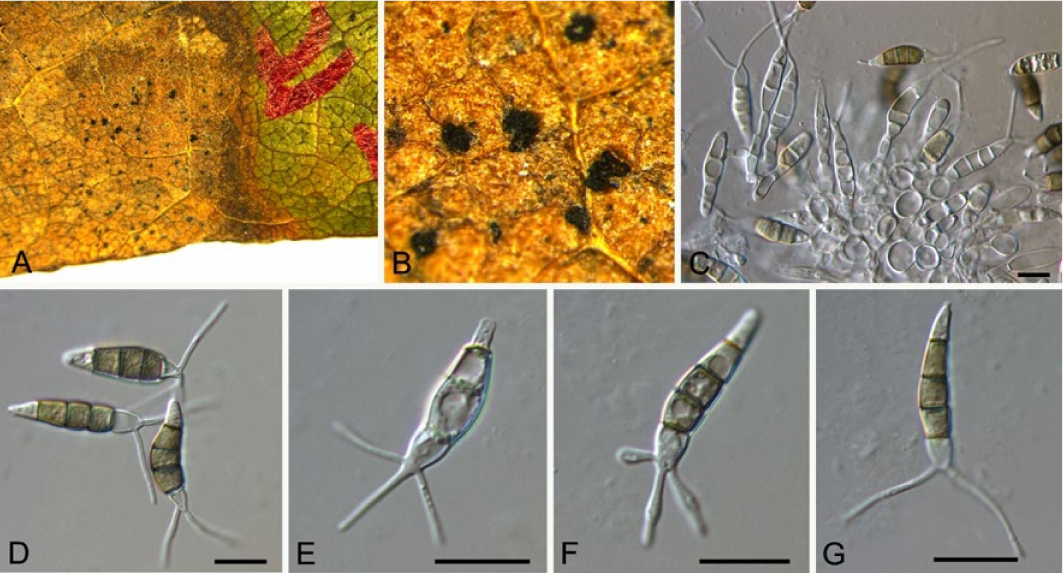
Figure 16. Neopestalotiopsis sichuanensis (BJFC-S1788). ( A , B ) Conidiomata on the diseased leaves of Castanea mollissima ; ( C ) Conidiogenous cells giving rise to conidia; ( D – G ) Conidia. Scale bars: ( C – G ) = 10 µ